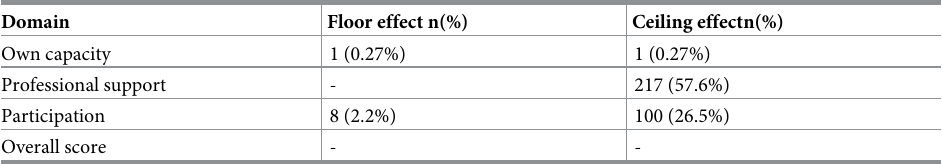
Table 7. Floor and Ceiling effects for each domain of the CEQ and for the total